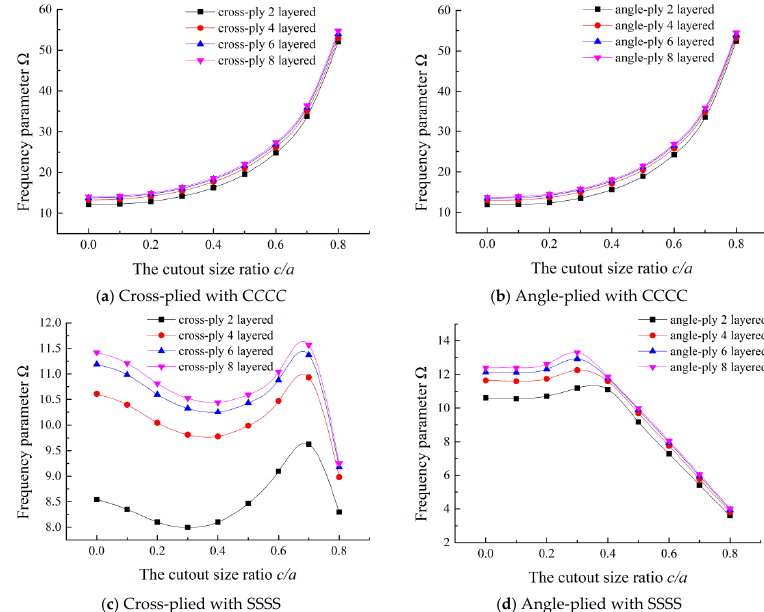
Figure 6. Fundamental frequency parameters of different laminations with various cutout sizes.